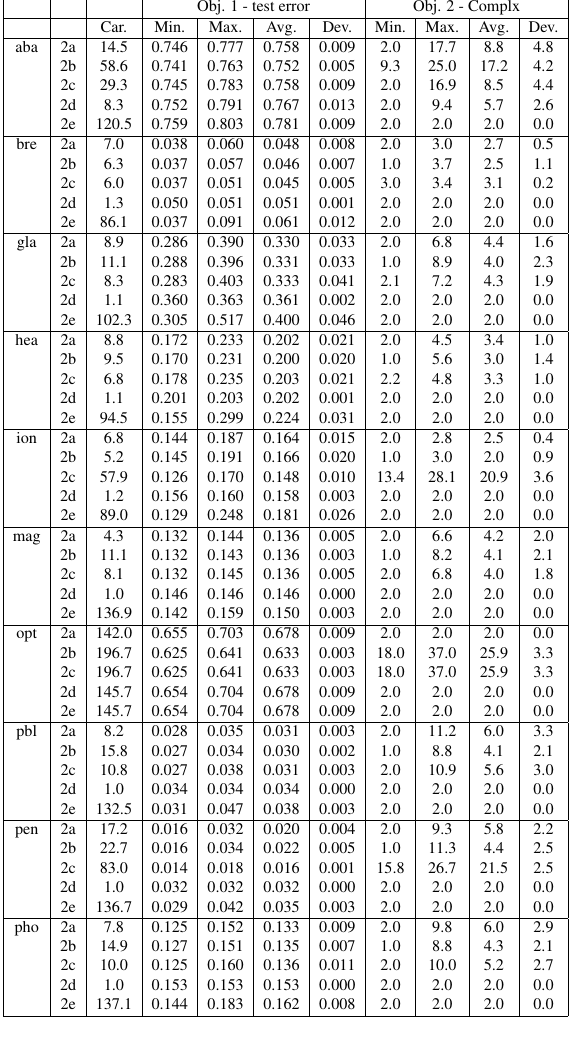
Table 6. Statistics of the Pareto front approximations with the global learning